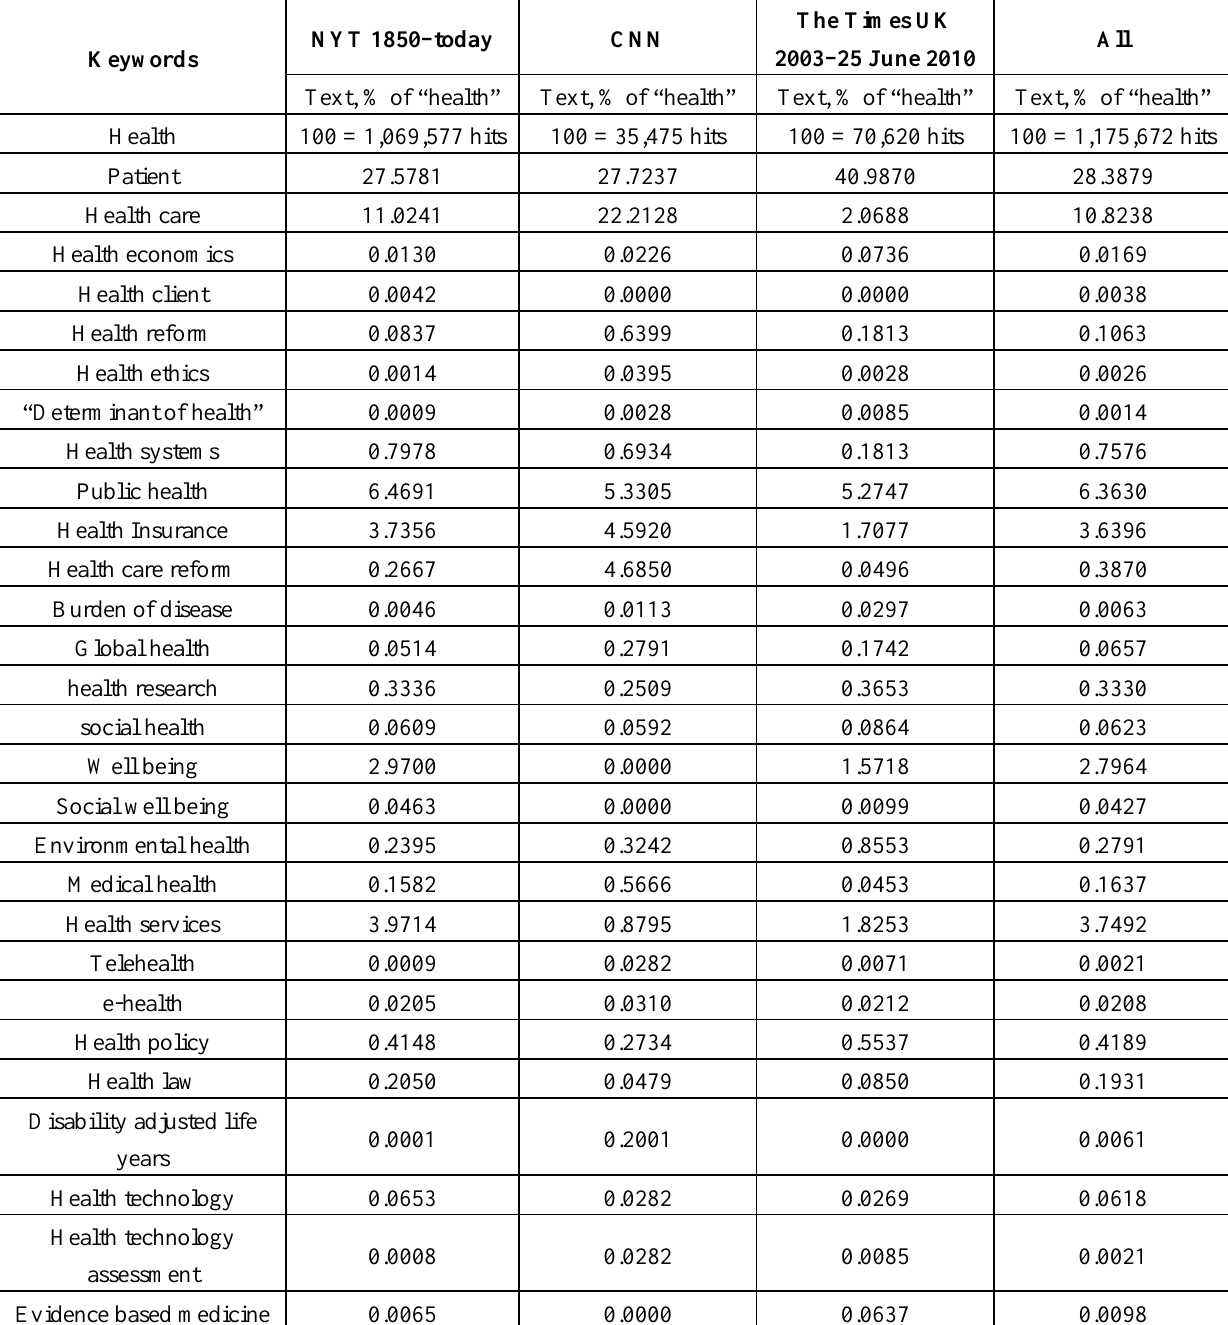
Table 4. Frequency of health policy terms covering different areas in the New York Times; The Times, UK and